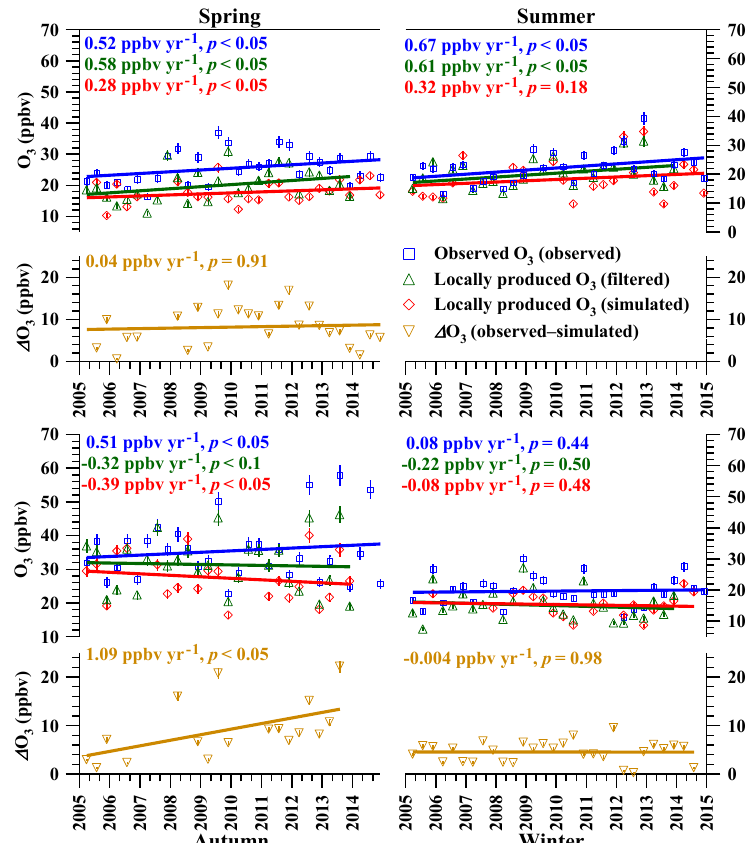
Figure 4. Trends of locally produced O 3 simulated by OBM (red line), observed O 3 (blue line: overall observed O 3 ; green line: locally produced O 3 (filtered), i.e. observed O 3 with hourly wind speed <2ms − 1 ), and regional O 3 (gold line, (cid:49) O 3 = O 3 overall observed – O 3 simulated) in four seasons at TC during the period 2005–2014. Note: all the data are based on daytime hours (07:00–19:00LT). The regional O 3 in summer was negligible and is not shown in the graph. Error bars represent 95% confidence intervals of the